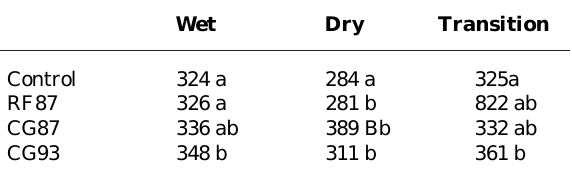
Table 7. Tukey test for soil water storage, considering three climatic periods (wet, dry, and dry-wet transition) among the treatments: control, gap centre from 1993 (CG93) and